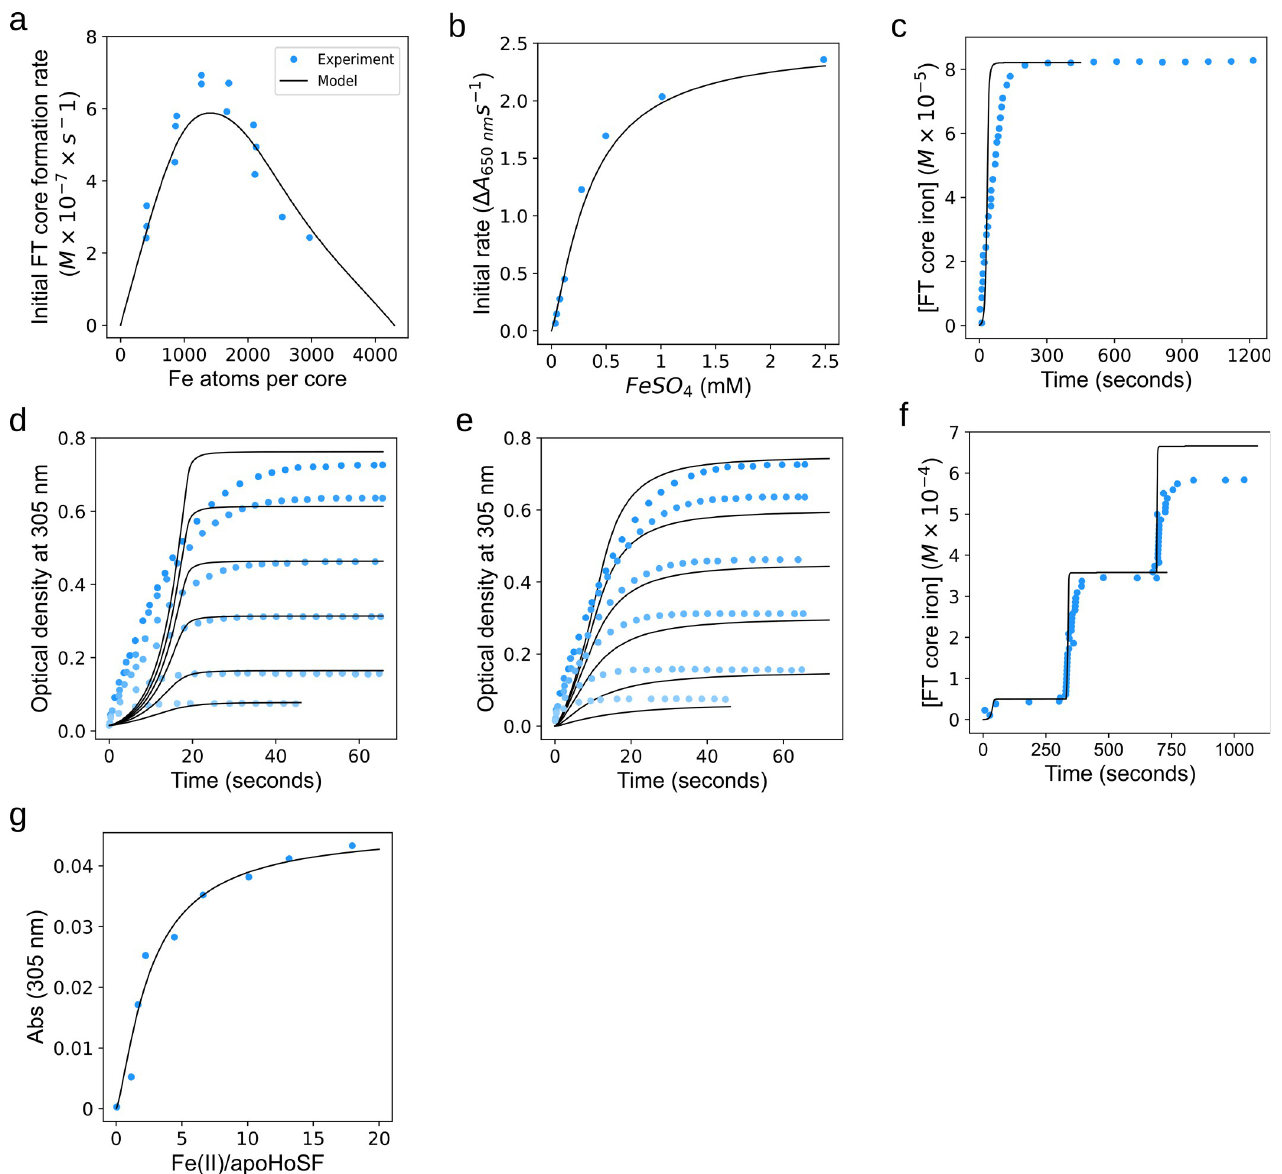
Fig 2. Model calibration and validation. a. Calibration. Using data from Harrison 1974 [40], parameter estimation was performed to determine the parameters for mineralization and nucleation. Following the parameter estimation, the model produced output (black line) that was a good representation of the experimental data (blue circles). Conditions: 4 H-chains/FT, 2.32 μ M FT, 470 Fe atoms per FT cage b-g. Validation. To validate the model, the model was run against four independent experimental conditions. For each experiment, the model parameters were preserved, only the initial concentrations were altered to match the experimental conditions. b. DFP formation over time (from Tosha 2008 [38] Fig 2B, Conditions: 24 H-chains/FT, 4.2 μ M FT, 1–600 Fe atoms per FT cage), c. Iron addition and mineralization (from Zhao 2003 [21] Fig 2, Conditions: 4 H-chains/FT, 0.2 μ M FT, 410 Fe atoms per FT cage). d and e. Mineralization from varied initial iron concentrations (from Fig 1 of Bou 2019 [39]), Conditions: 24 H-chains/FT, 0.5 μ M FT. Each time course represents an experimental condition where the FT concentration is the same and the initial iron added was varied. From bottom to top, the amount of iron atoms added per FT cage was 42, 100, 200, 300, 400, 500. f. Iron addition and mineralization (from Zhao 2003 [21] Fig 3, Conditions: 24 H-chains/FT, 0.5 μ M FT, 100 and then 700 and 700 Fe atoms per FT cage). g. Iron addition and mineralization (from Zhao 2005 [41] Fig 2B, Conditions: 4 H-chains/FT, 22 μ M FT, 0–20 Fe atoms per FT